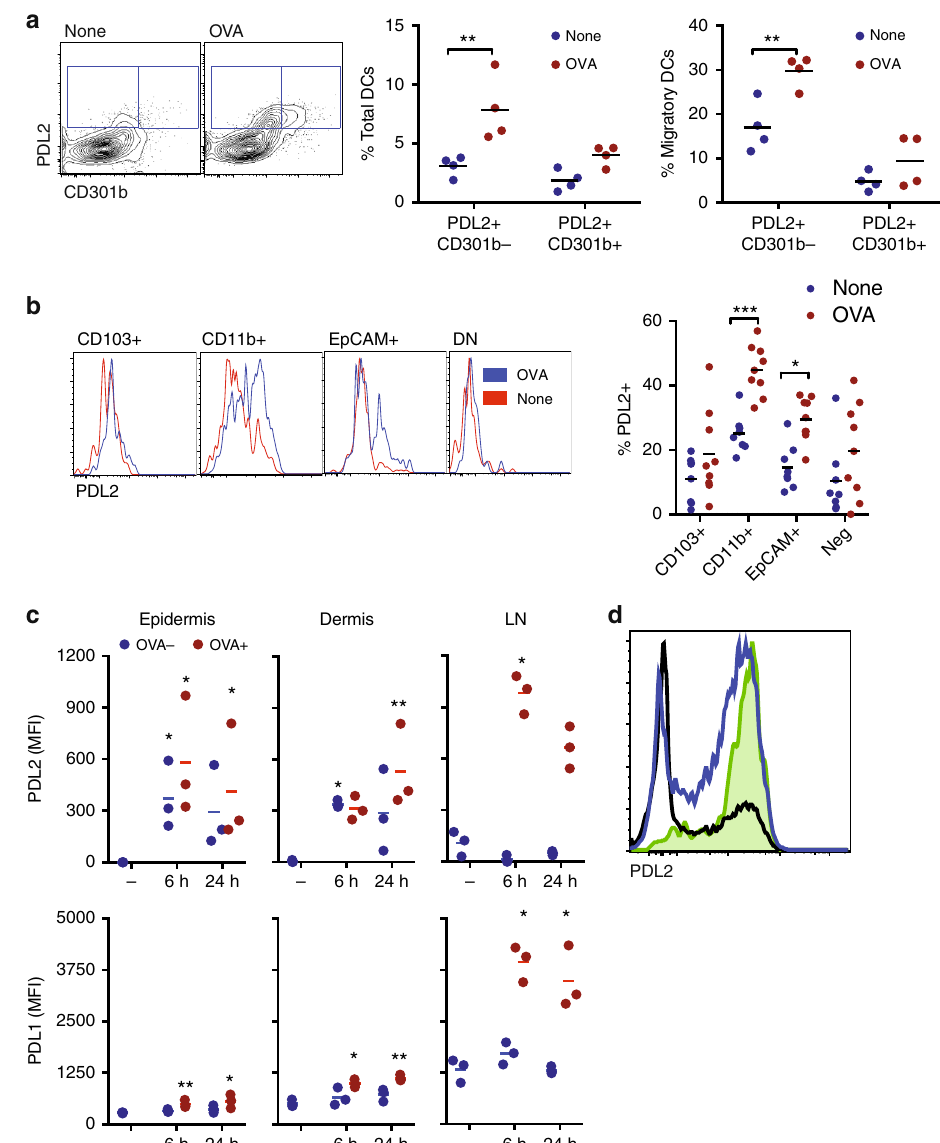
Fig. 6 PDL2 + DCs in skin-draining lymph nodes after epicutaneous antigen exposure. a Expression of PDL2 and CD301b by CD11c + MHCII + DCs in brachial lymph nodes of Balb/c mice treated with OVA (red) for 48 h and untreated mice (none)(blue). N = 4 mice/group. b Representative plots of the expression of PDL2 by the different DC subsets, and percentage of PDL2 + in the different DC subsets. N = 8 mice/group. * p < 0.05, ** p < 0.01, *** p < 0.001, Two-way Anova, Sidak ’ s multiple comparison test. c Expression of PDL2 and PDL1 (median fl uorescence intensity, MFI) in OVA + (red) or OVA − (blue) LCs of the epidermis, or DCs of the dermis or lymph node (LN). Tissues were harvested 6 or 24 h after patch placement, – indicates control mice in which no patch was placed. N = 3 mice per group. * p < 0.05, ** p < 0.01, Kruskal – Wallis test with Dunn ’ s comparison. d Representative fl ow cytometry showing PDL2 expression in total DCs (black line), migratory DCs (blue line), or OVA + DCs (shaded green) in the lymph